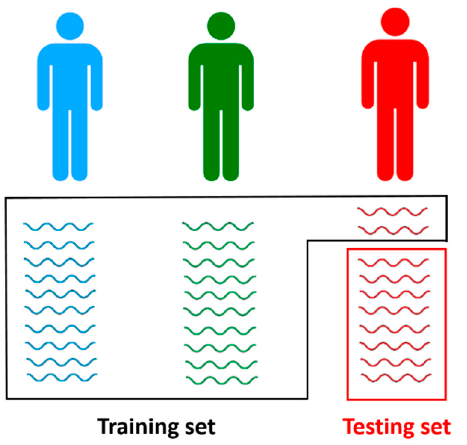
Figure 6. Example of one-fold (iteration) of the partial blind testing protocol. In this fold, the training set is composed of the first two subjects’ samples (blue and green subjects) plus a limited number of samples from the testing subject (red subject). The latter small part extracted from the testing subject is important for calibration purpose.